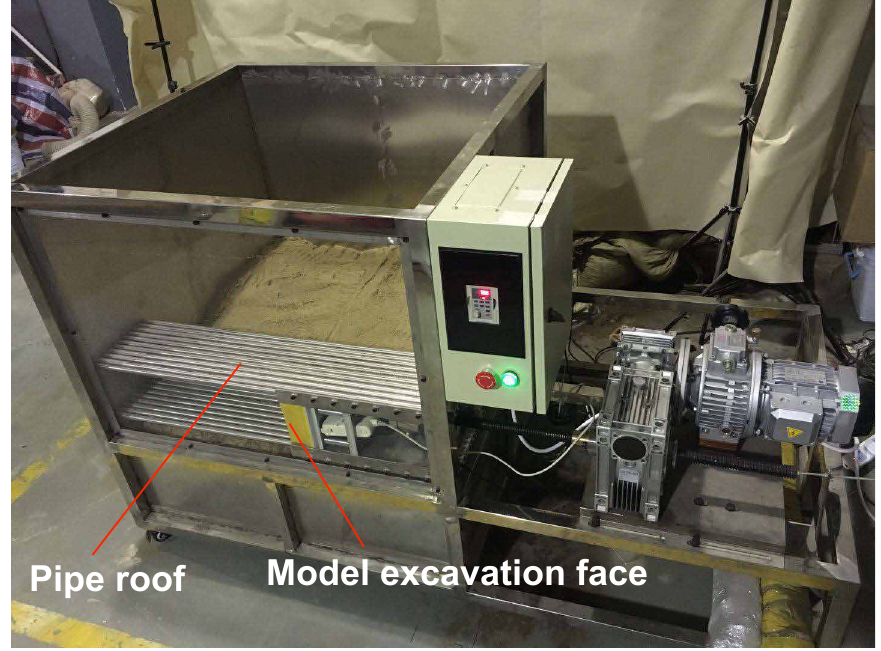
Figure 2. Box used in the experimental